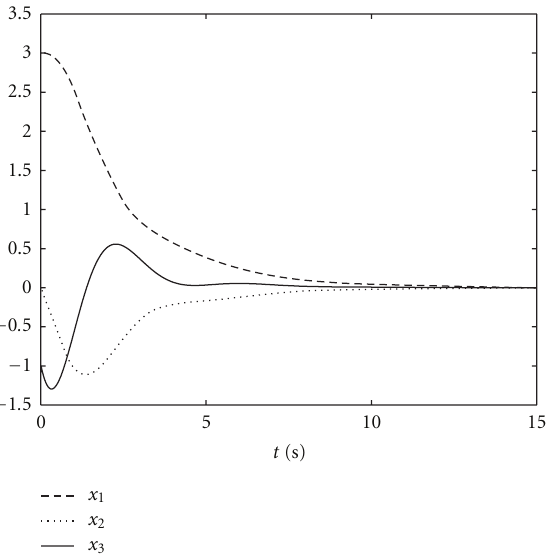
Figure 3: State x ( t ) of the controlled Genesio’s system.